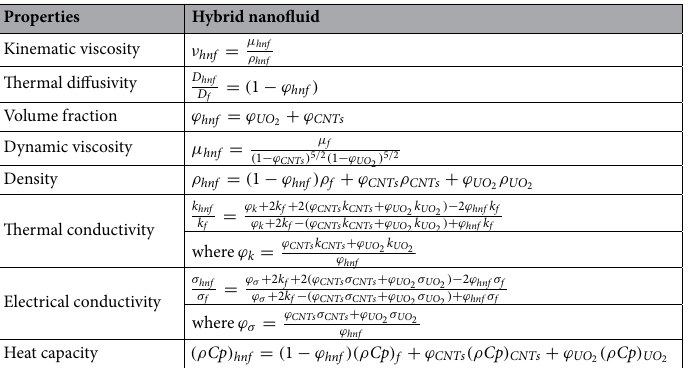
Table 2. Maxwell model for thermophysical characteristics of the hybrid nanofluid 50–53